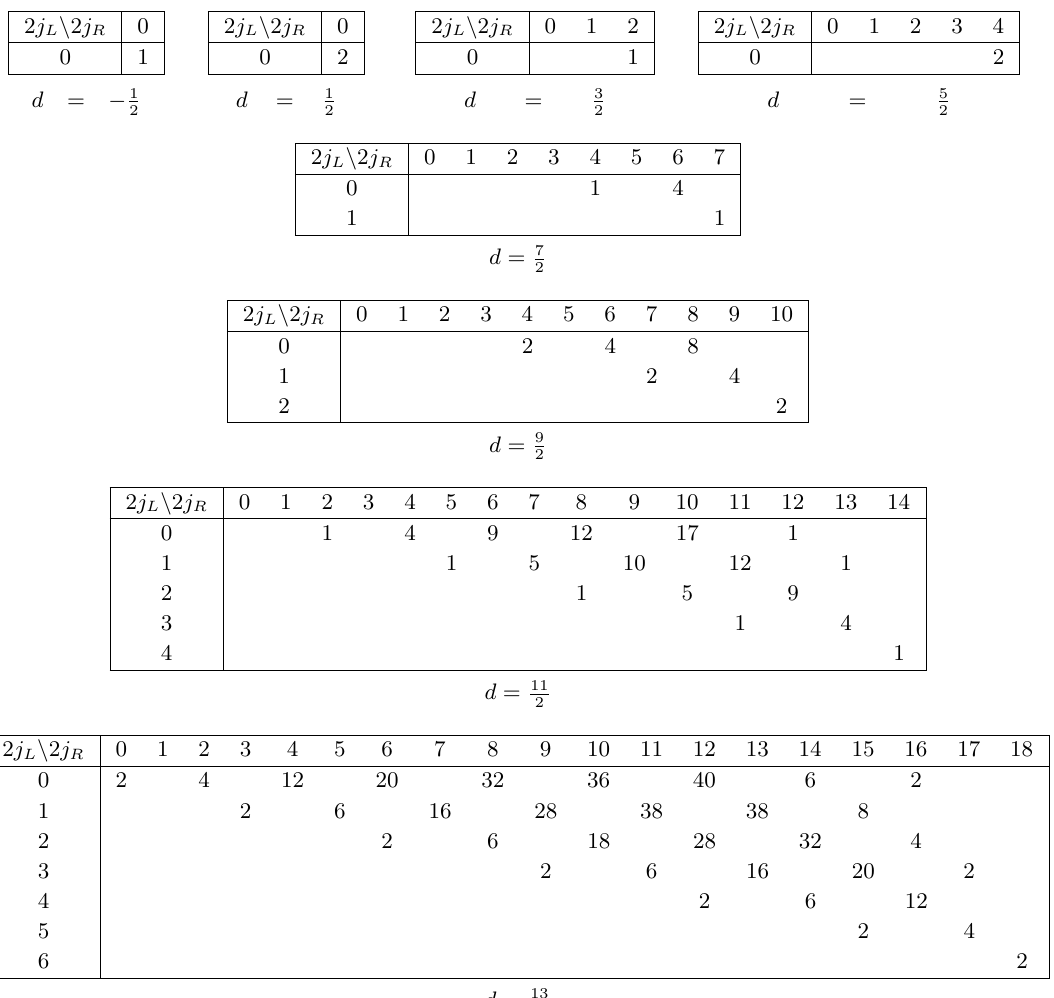
Table 10 . BPS spectrum of Wilson loop for local P 1 × P 1 in the representation 2 of SU(2) for the curve class dt = 2 dφ